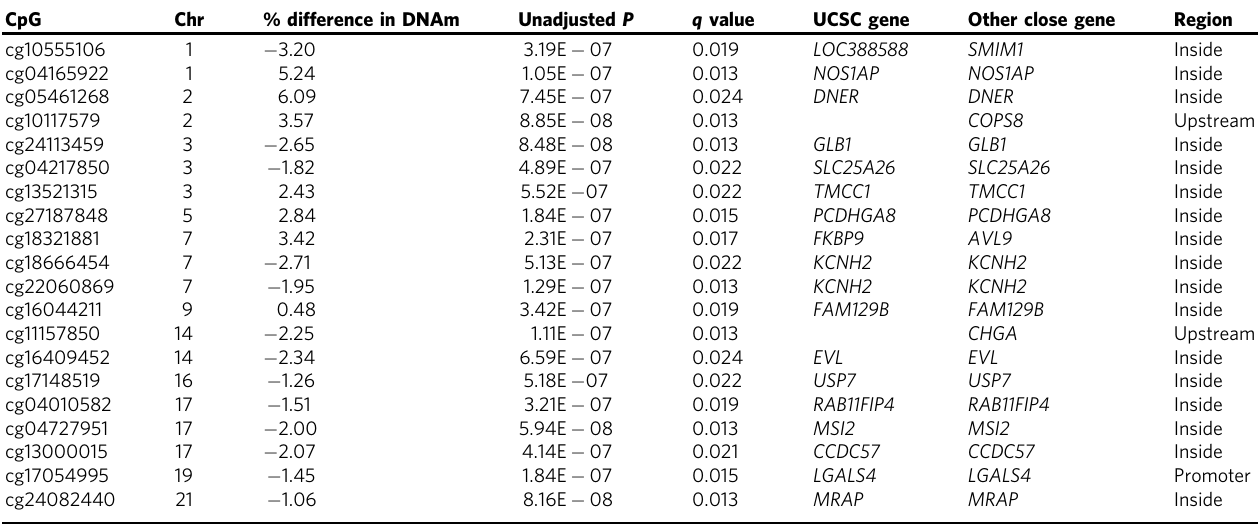
Chr chromosome, DNAm DNA